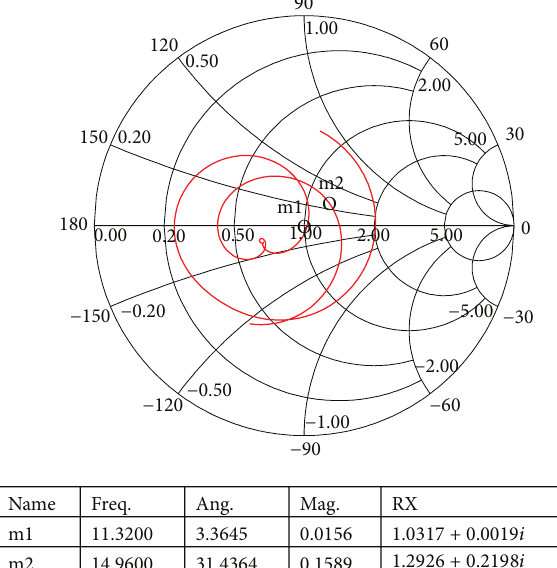
Figure 16: Smith chart of the proposed antenna.